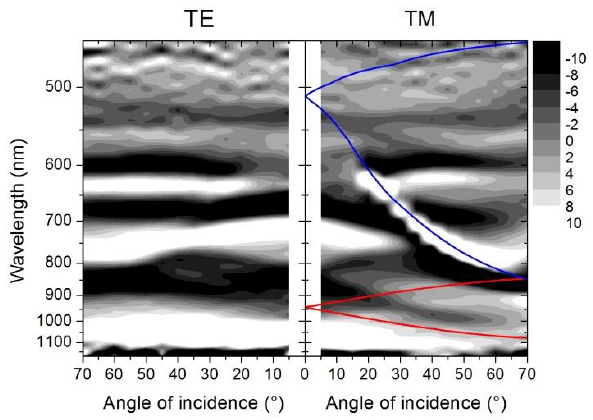
Figure 7. Dispersion map of the second derivative of the reflectance of the TE and TM light polarization in the final Au/SiΠ structure.